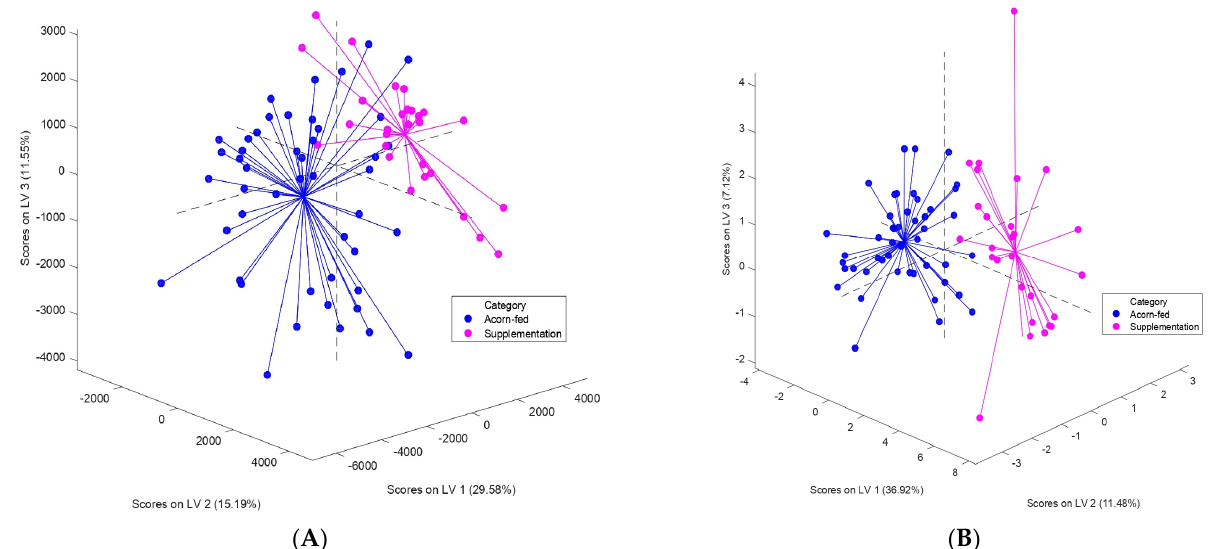
Figure 2. Score plots of PLS-DA models performed: ( A ) Model 1: non-targeted (spectral fingerprint) approach; ( B ) Model 2: targeted (individual features) approach (21 features). approach; ( B ) Model 2: targeted (individual features) approach (21